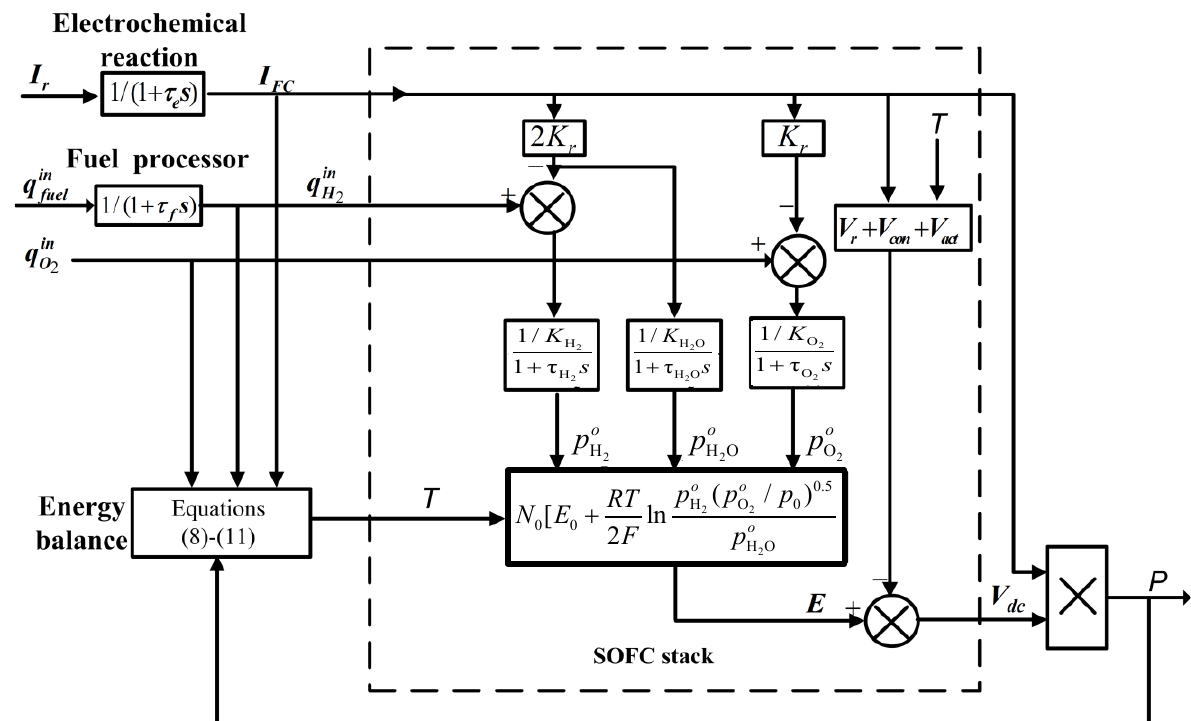
Figure 1. The benchmark solid oxide fuel cell (SOFC) dynamic